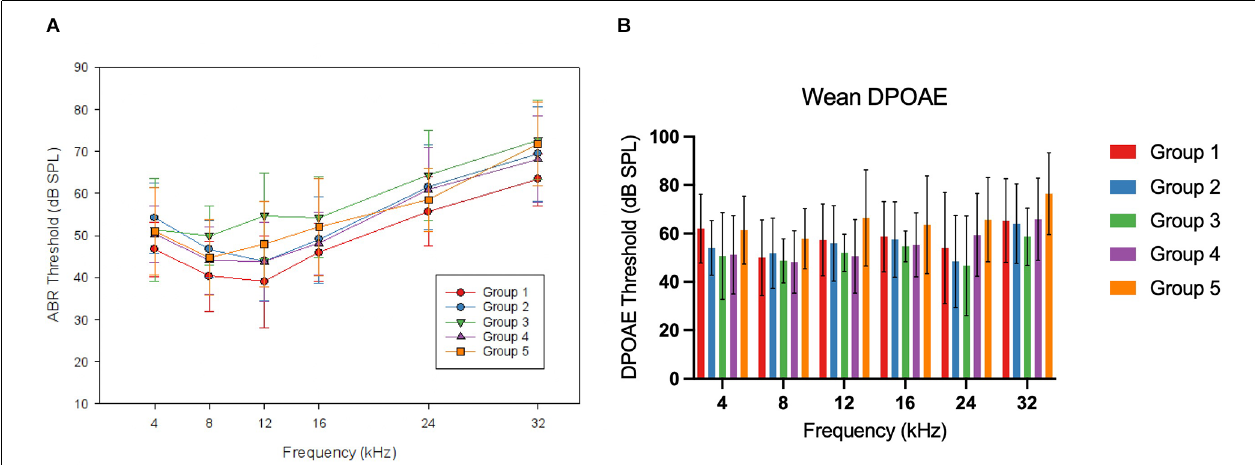
FIGURE 3 | Wean ABR and OAE. Panel (A) shows the mean ABR thresholds for each group of offspring mice at wean. No frequency-specific differences were reported at this time point. Mean thresholds for Group 1 were lower than in Groups 2, 3, and 5 ( p < 0.05). Panel (B) shows the mean DPOAE thresholds for each group of offspring mice at wean. No significant differences were seen at this time point. Error bars represent ± 1